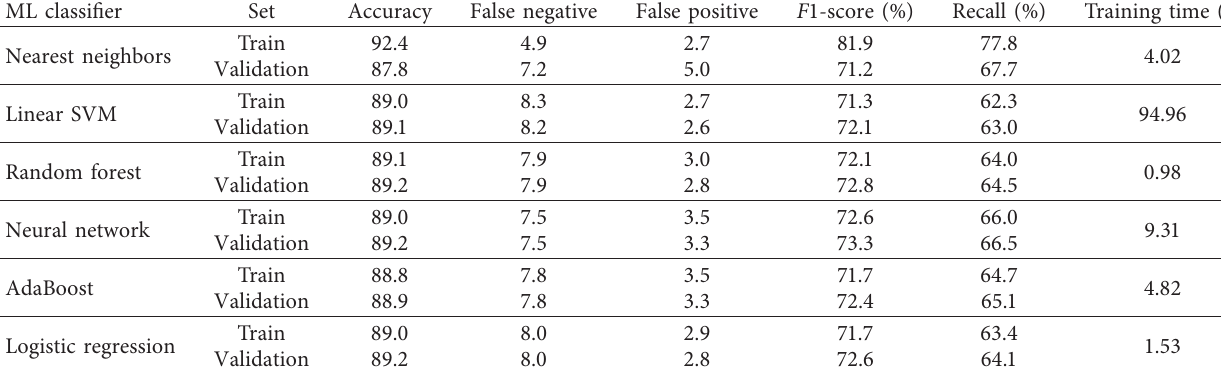
Table 3: Machine learning classifiers performance with TH � 50 for the FD004 subdataset.